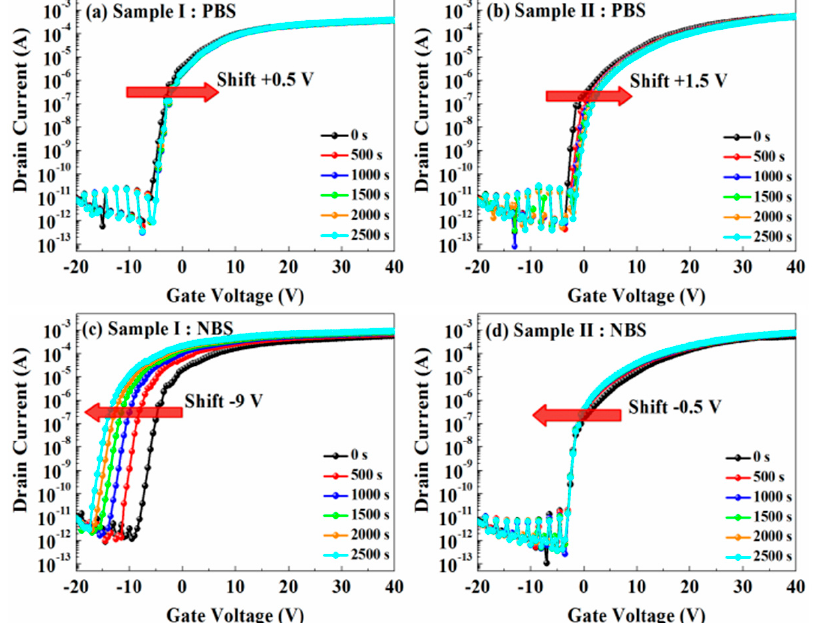
Figure 5. Bias stress stability of the N-doped DSCL TFTs: ( a ) positive bias stress (PBS) of the a-IGZO:N/a-IZO:N TFT (Sample I); ( b ) PBS of the a-IZO:N/a-IGZO:N TFT (Sample II); ( c ) negative